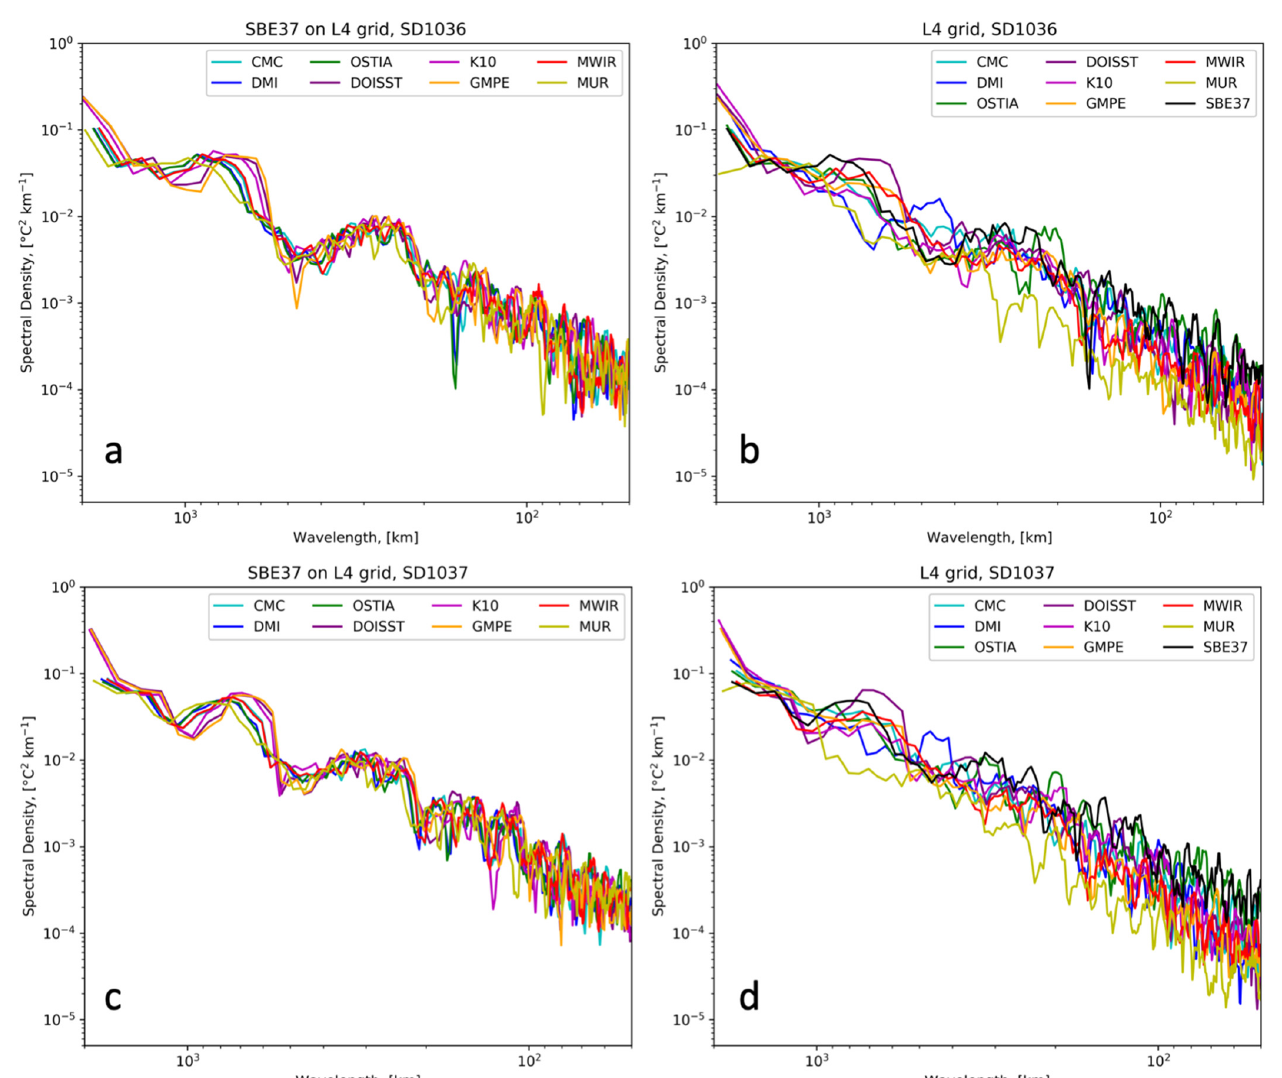
Figure 7. Autospectral comparisons for the saildrone-borne SBE37 SSTs on eight GHRSST L4 grids (left column) ( a ) SD1036, ( c ) SD1037, and the L4 SST products themselves (right column) for ( b ) SD1036 and ( d ) SD1037. The density spectrum of the SBE37 on the OSTIA grid is also included with the L4 autospectra (panels ( b , d )) for comparison purposes.